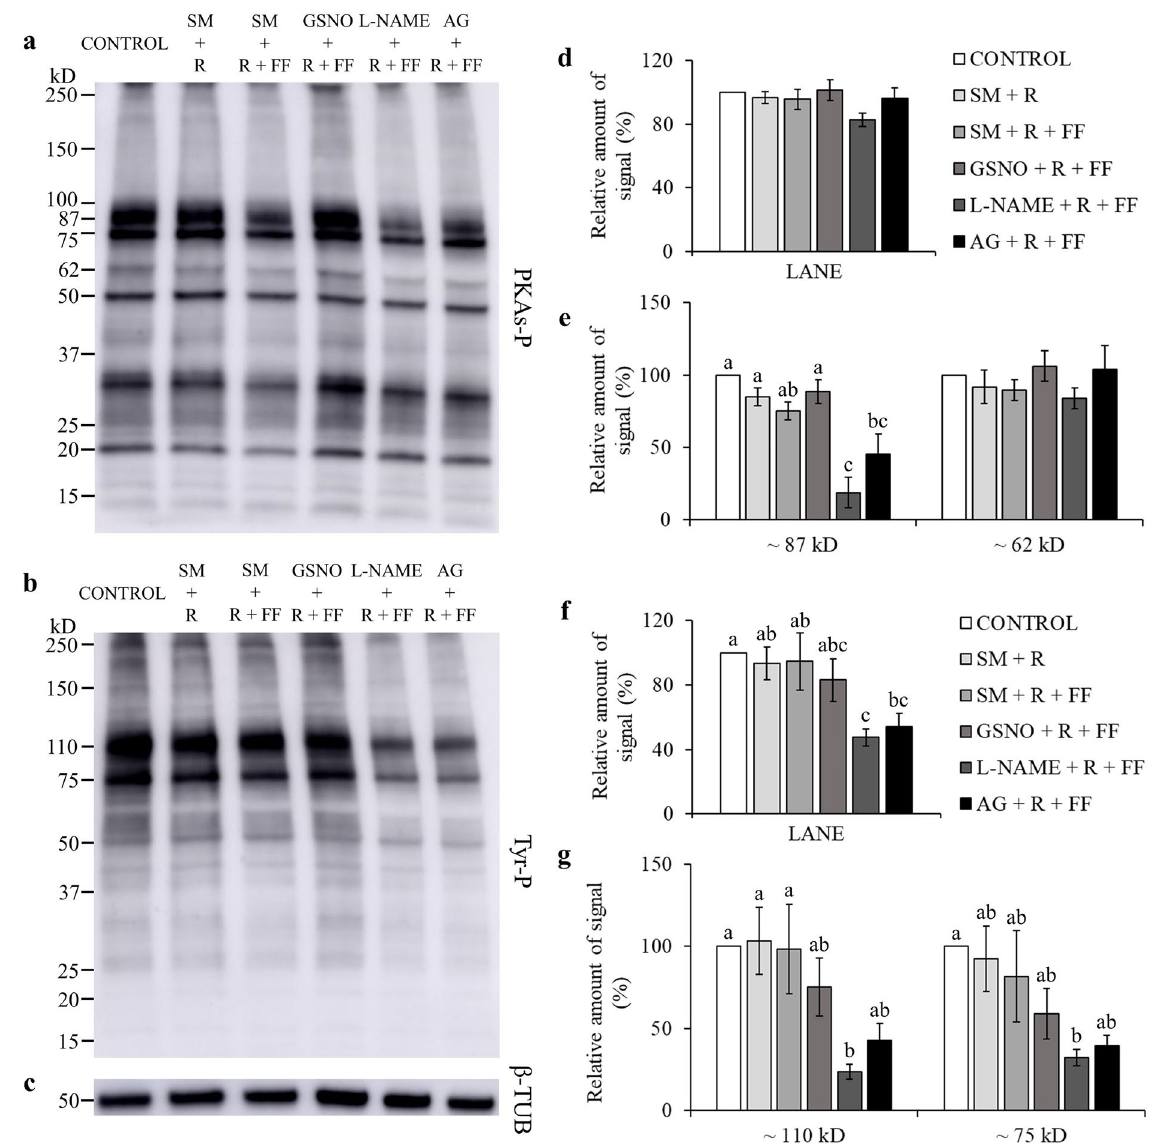
Figure 4. Effect of L-Arginine (R), follicular fluid (FF), GSNO, l-NAME, and AG on PKA substrates (PKAs-P) and tyrosine phosphorylation (Tyr-P). Sperm were incubated for 4 h under capacitating conditions in the absence of any treatments (CONTROL) or in the presence of L-Arginine, the substrate for NO synthesis, follicular fluid, GSNO, a NO donor, l-NAME and AG (both NOS inhibitors). ( a,b ) Sperm protein extracts (n = 7) were analyzed for phosphorylation by Western blot using anti-PKAs-P or anti-Tyr-P as first antibodies, respectively. ( c ) β-tubulin (β-TUB) was used as a protein loading control. For signal quantification, each lane was normalized to its β-TUB optical density value. ( d–g ) Relative amount of signal quantified in each membrane using ImageQuant TL v8.1 software for PKAs-P and Tyr-P, respectively. SM: Sperm Medium. Different letters (a, b, c) indicate statistically significant differences ( P < 0.05) between groups. Images ( a – c ) were cropped from the corresponding blot showed in Supplementary Fig. S4 (lanes